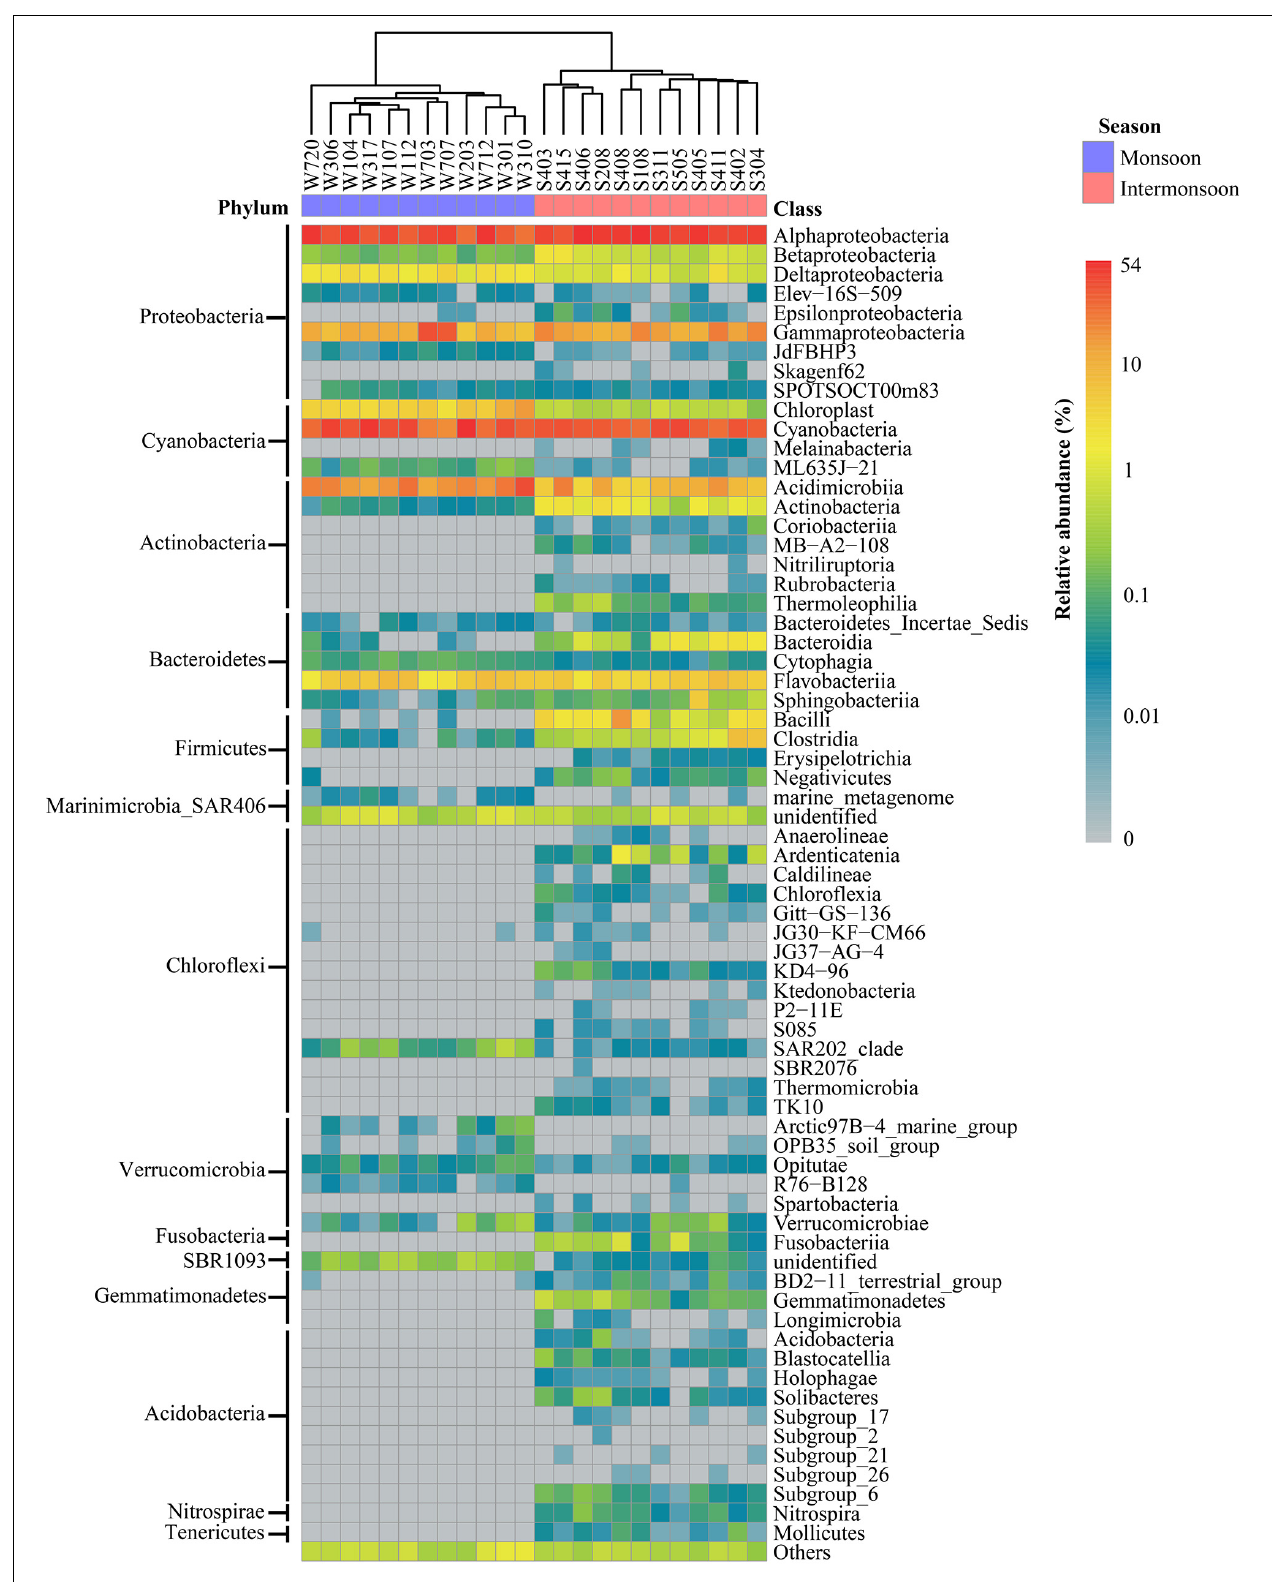
FIGURE 1 | Bacterial community composition at class level in the Eastern India Ocean (EIO) in the monsoon and intermonsoon.